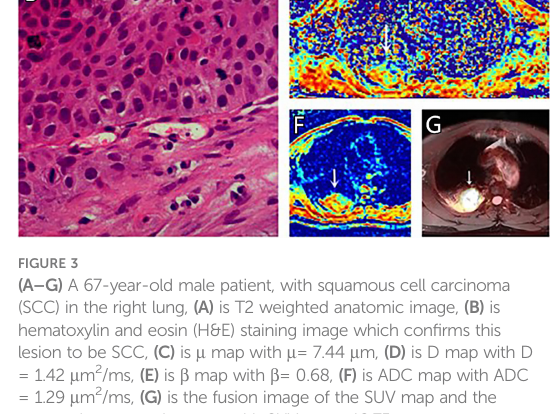
TABLE 3 Mean and consistency analysis of parameters as respectively measured by both